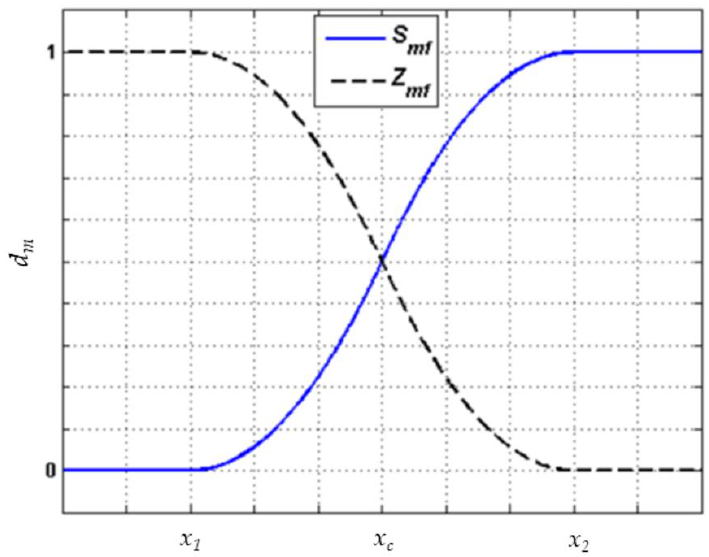
Figure 7. S (blue line) and Z (dashed black line) membership functions.